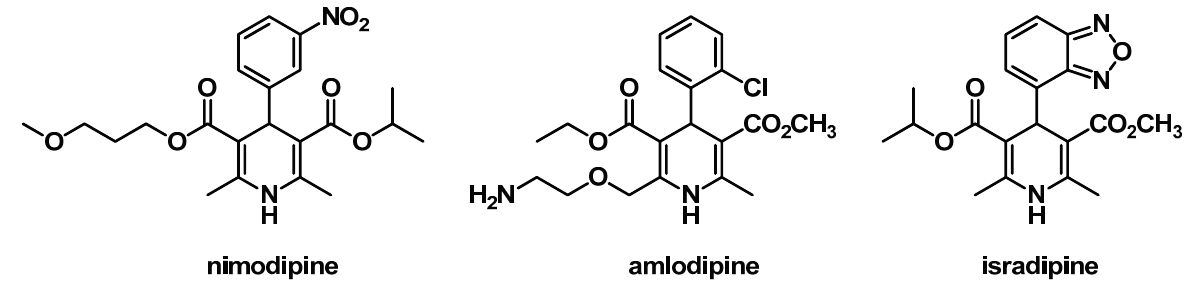
Figure 1. Selected 1,4-dihydropyridine (DHP) Ca 2+ -channel